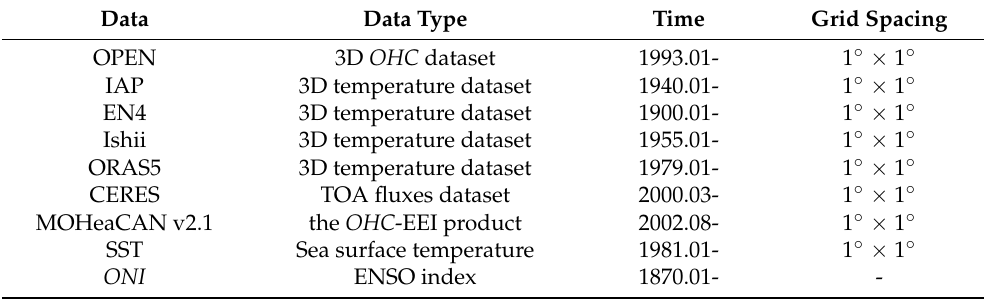
Table 1. Data used in this